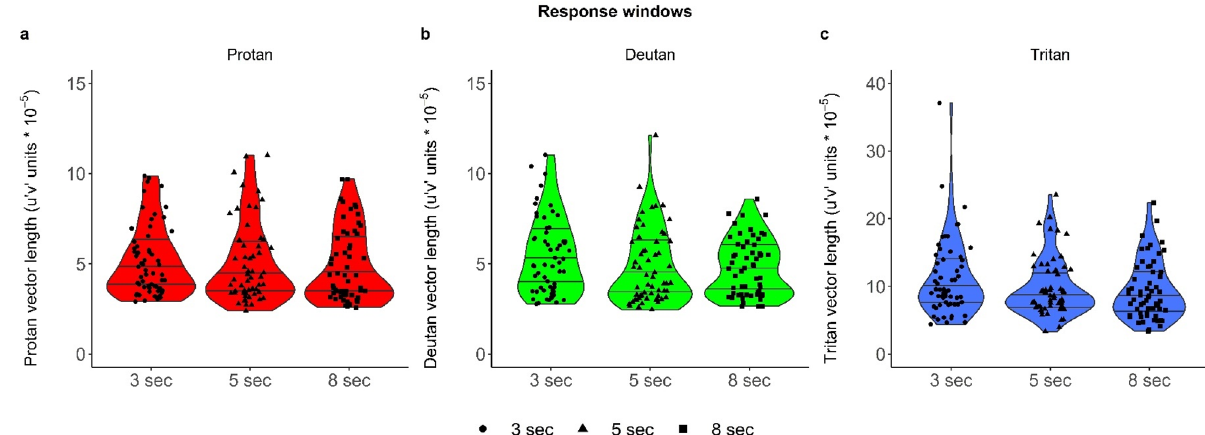
Figure 2. Violin plots representing discrimination thresholds of individual observers at the 3-s, 5-s and 8-s response windows for each of the three Trivector measures: ( a ) Protan, ( b ) Deutan and ( c ) Tritan. Observe that the y-axis scale of Tritan thresholds ( c ) differs from those of Protan ( a ) and Deutan ( b ) thresholds. Horizontal lines denote 25%, 50% and 75% quartiles. The shape of the violin plots is determined using a Gaussian kernel